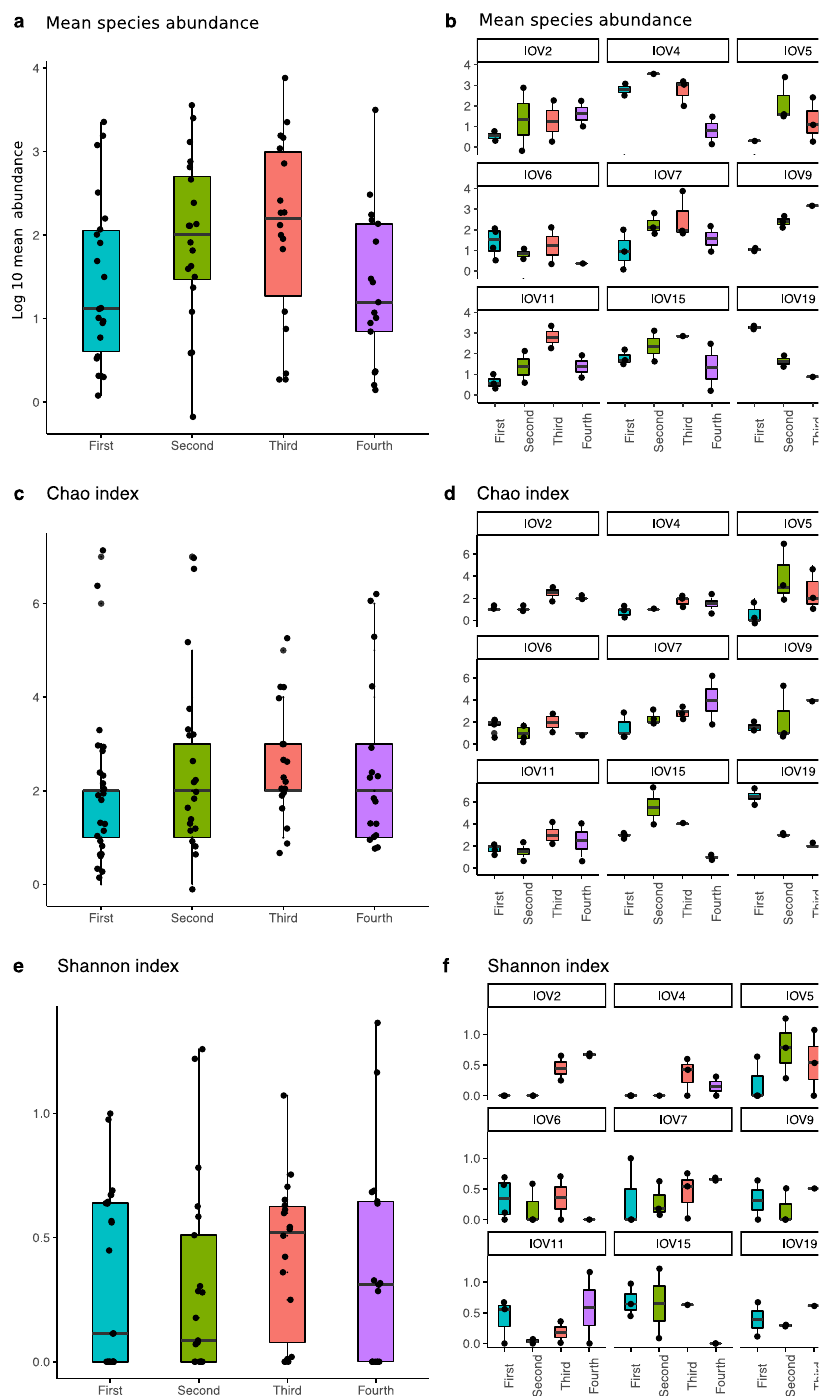
Figure 3. Bar plots comparing human eukaryotic viral diversity measures in the oropharynx analyzed by trimester of life, each point indicates a sample. ( a ) Mean of species abundance in all children samples, expressed in logarithm base 10; ( b ) Mean of species abundance per child, expressed in logarithm base 10; ( c ) Number of species in all children samples, calculated by the Chao richness index; ( d ) Chao richness index in each child; ( e ) Virus diversity in all children samples, calculated with the Shannon diversity index; ( f ) Shannon index of samples per child. In graphs ( b ), ( d ), and ( f ) the identifier IOV (infant oral virome) is at the top, and each quarter is indicated at the